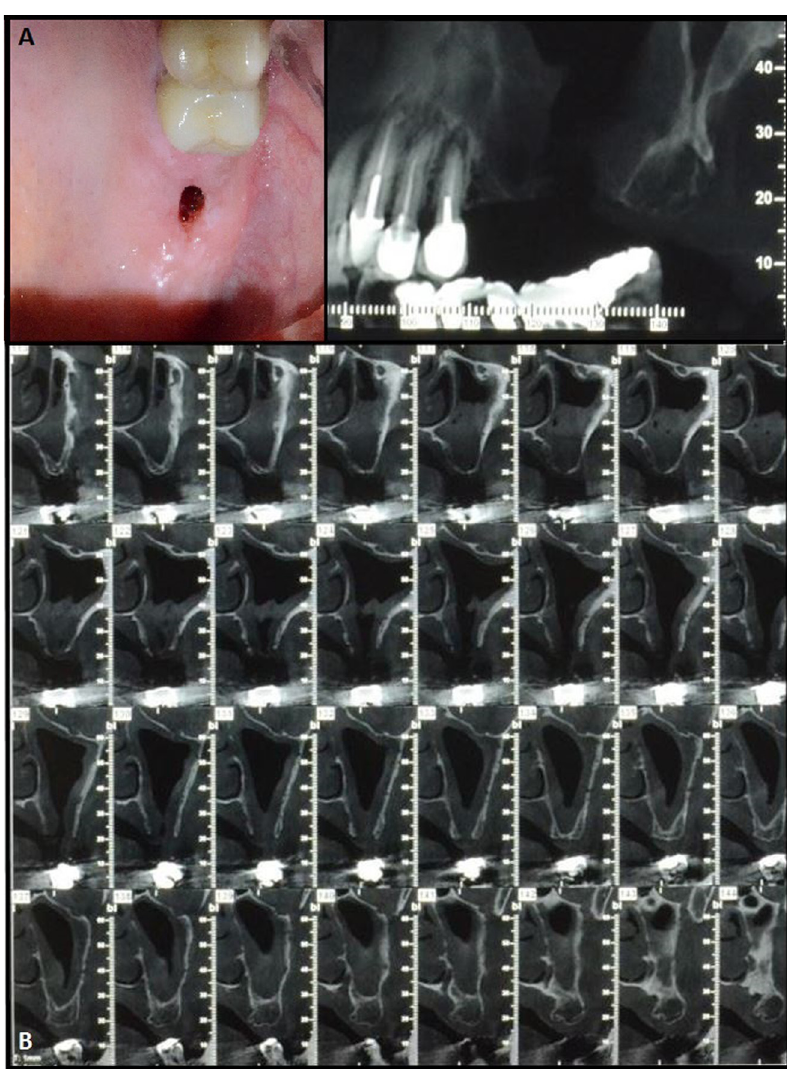
Fig. 1. (A) Clinical picture of the fi stula. (B) CBCT performed after the fi rst